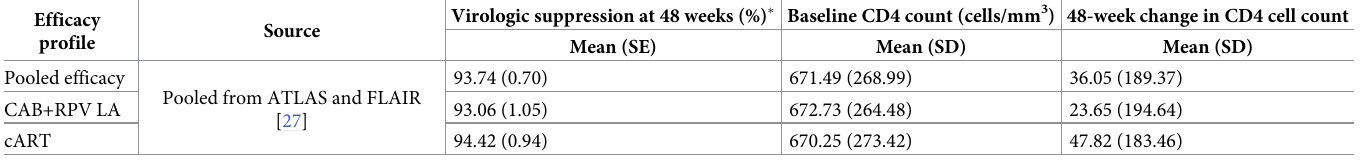
Table 1. ART efficacy by virologic suppression and change in CD4 cell count. Efficacy profile